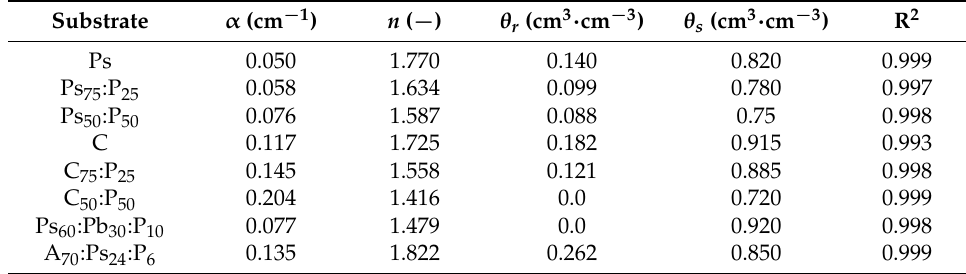
Table 3. The Mualem–van Genuchten model fitting parameters α, n , θ r and measured values of θ s for the substrates.